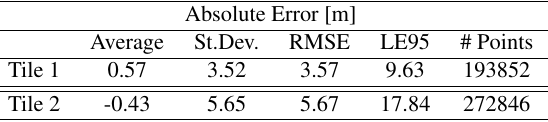
Table 2: Results of DSMs